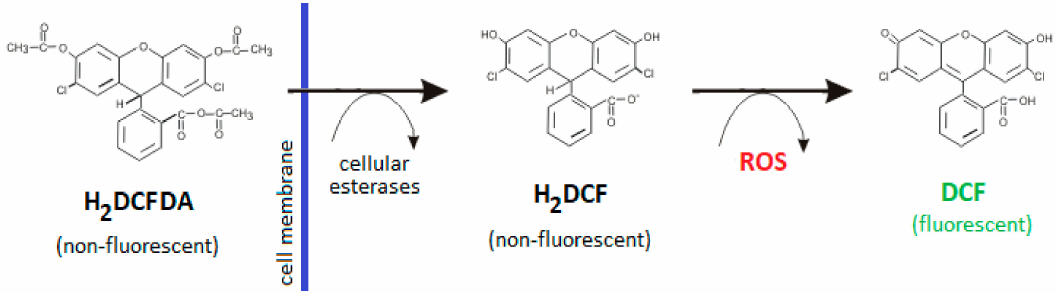
Figure 8. The principle of ROS level measurement using H 2 DCFDA probe. 2 (cid:48) ,7 (cid:48)